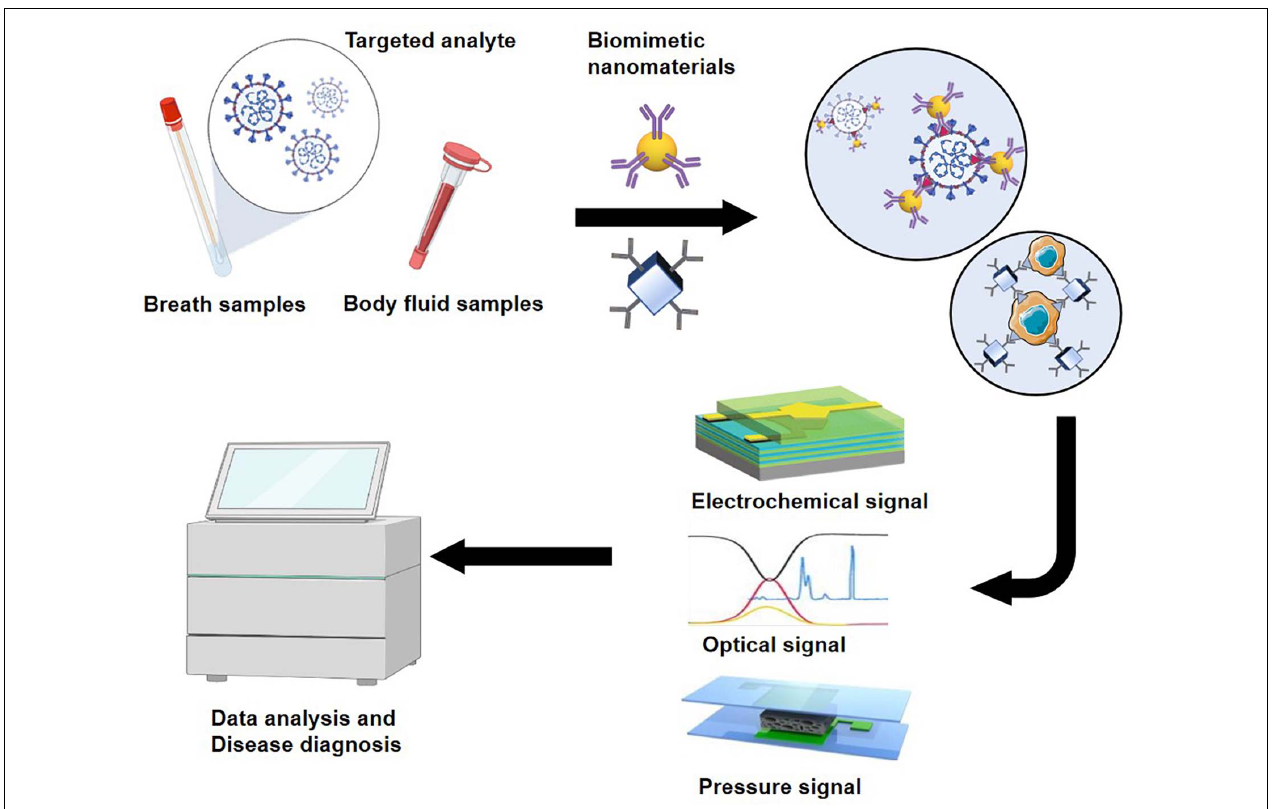
FIGURE 2 | Schematic diagram of biomimetic nanomaterials applied to